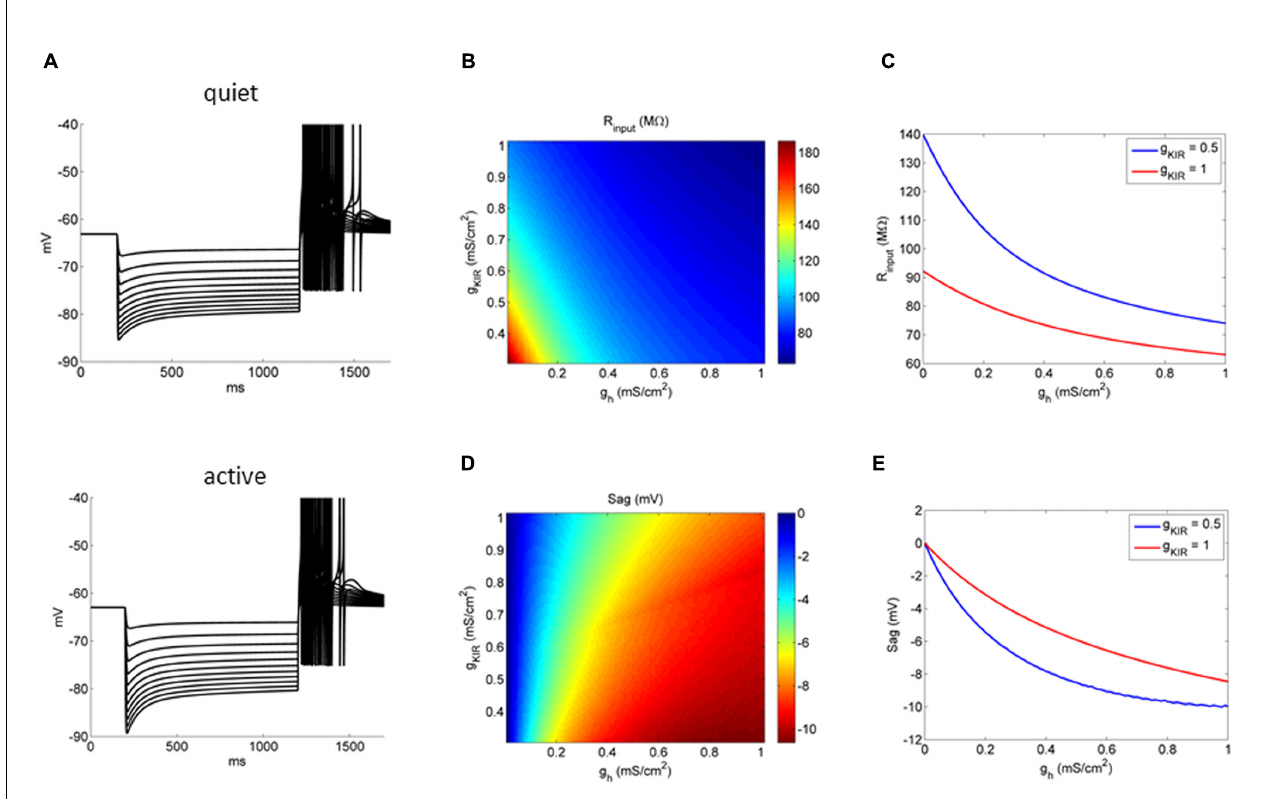
FIGURE 8 | Influence of g K ir on the impact of g h on the membrane input resistance and response to hyperpolarizations. (A) Example of the behavior of a quiet and active fusiform neuron model to successive hyperpolarizations. (B) Conductance space of g h versus g Kir affecting membrane input resistance (color coded). (C) Two examples showing the effect of increasing g h on the membrane input resistance in two models: one with a g Kir typical of quiet neurons (red) and the other with a g Kir typical of active neurons (blue). (D) Conductance space of g h versus g Kir affecting membrane depolarization sag (color coded). (E) Two examples showing the effect of increasing g h on the membrane depolarization sag in two models: one with a g Kir typical of quiet neurons (red) and the other with a g Kir typical of active neurons